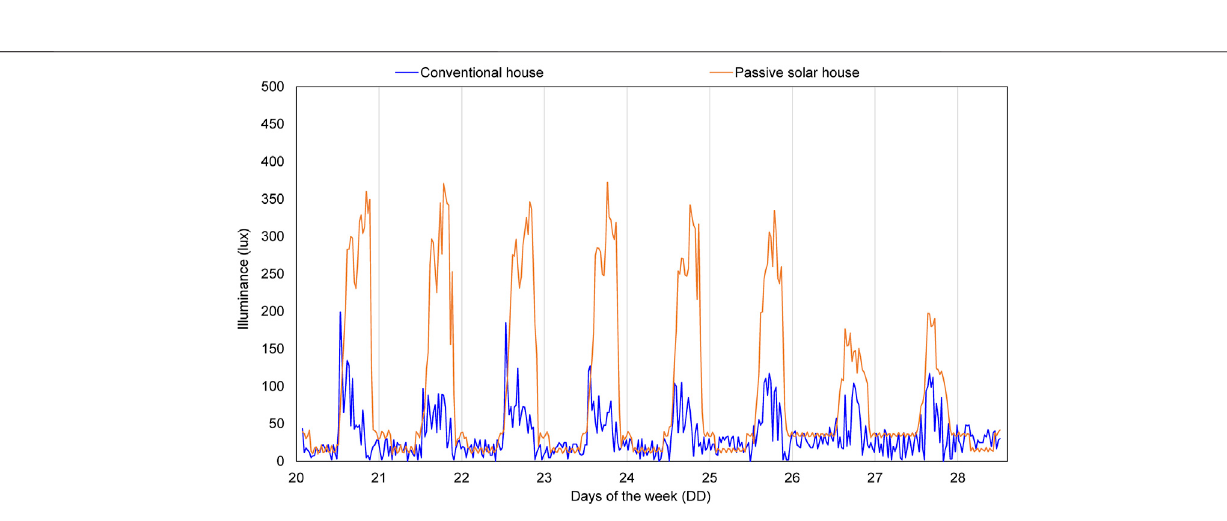
FIGURE 5 | Indoor illuminance